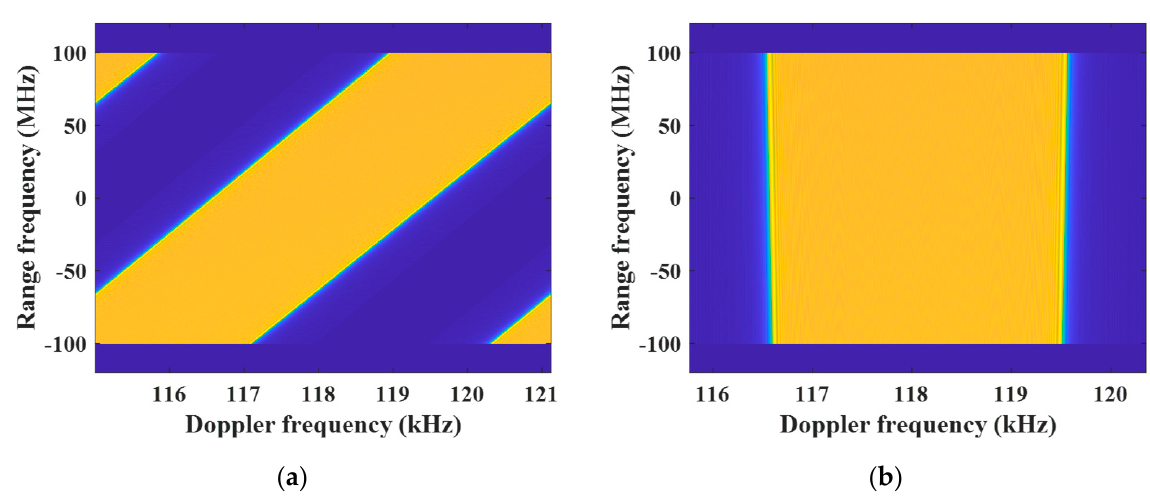
Figure 10. 2D frequency spectrum in the squint case. ( a ) 2D frequency spectrum before de-skewing; ( b ) 2D frequency spectrum after de-skewing.